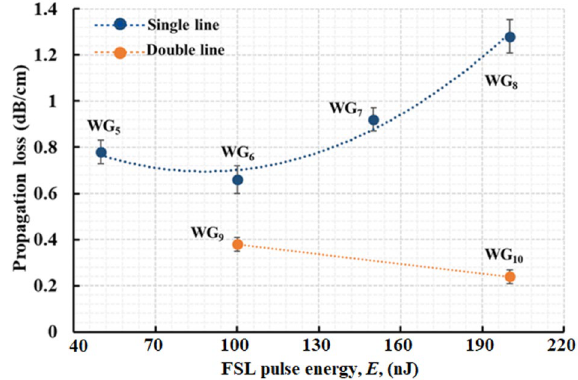
Figure 6. PL in single line induced WGs (WG 5 –WG 8 in blue) and double line induced WGs (WG 9 –WG 10 in brown) as a function of FSL pulse energy. Minimum PL of ~ 0.2 dB/cm is measured for WG 10 .